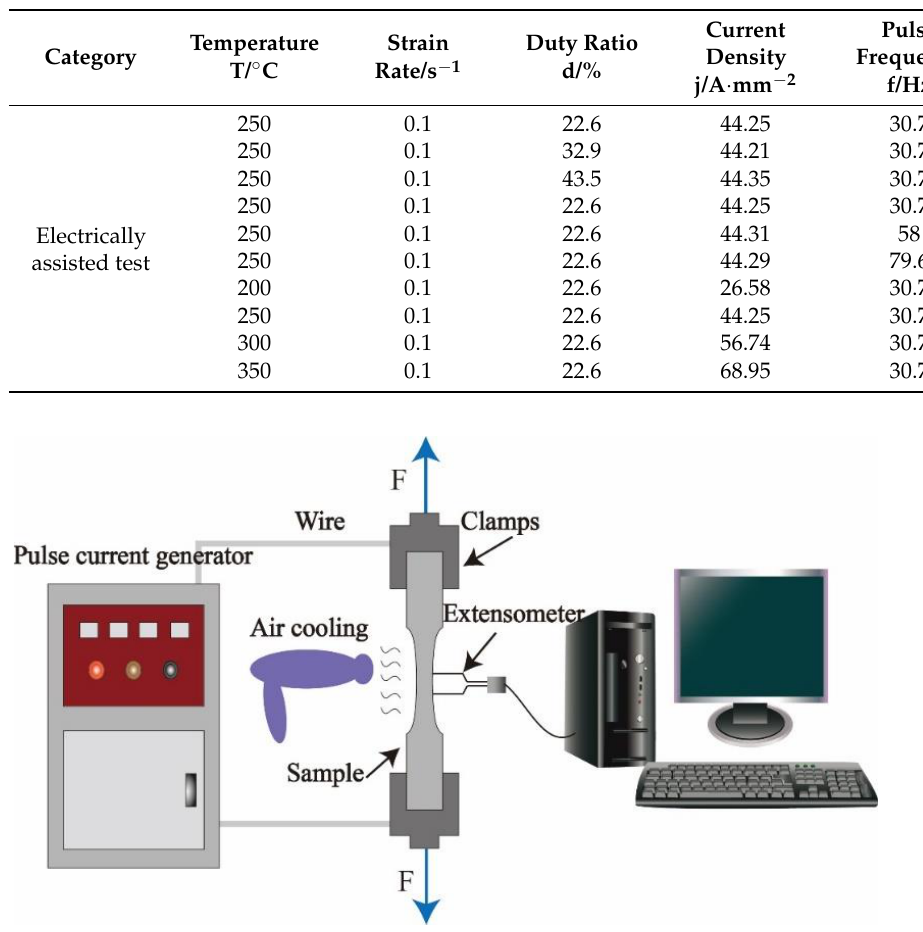
Figure 2. Schematic diagram of the electrically assisted tensile test.